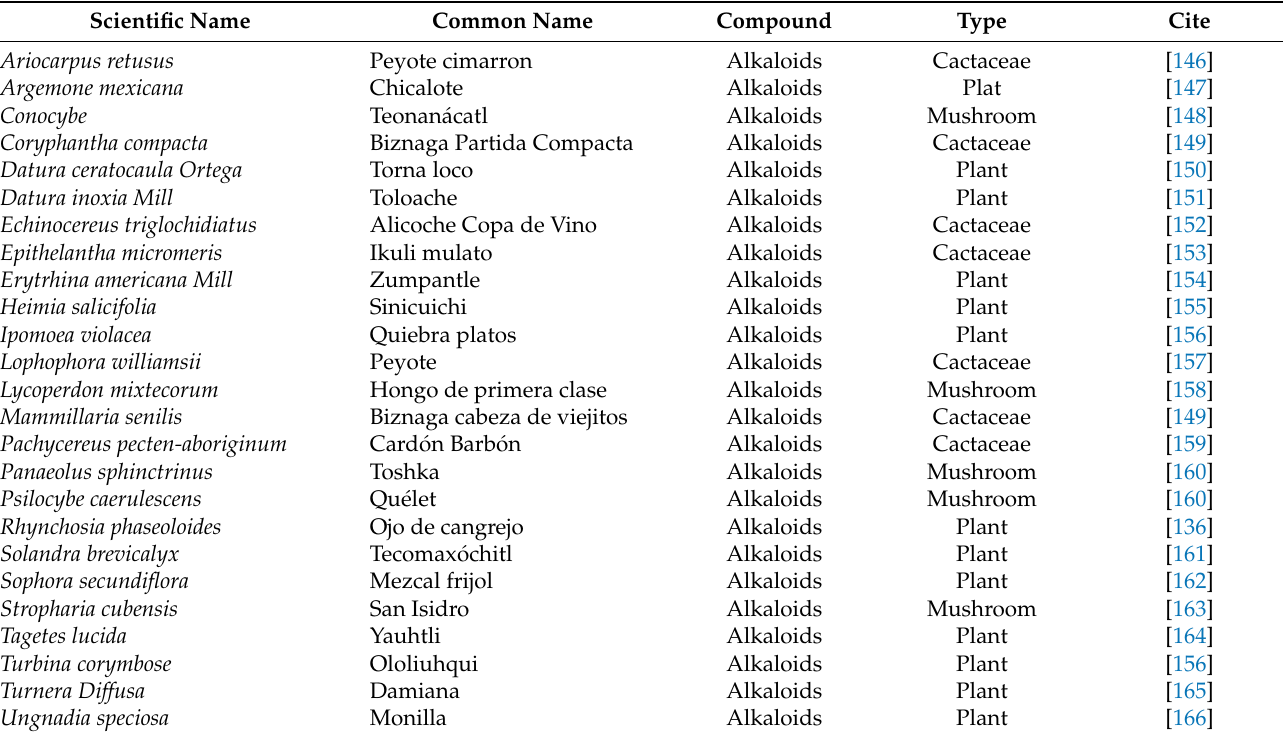
Table 2. List of Mexican sacred plants without studies of